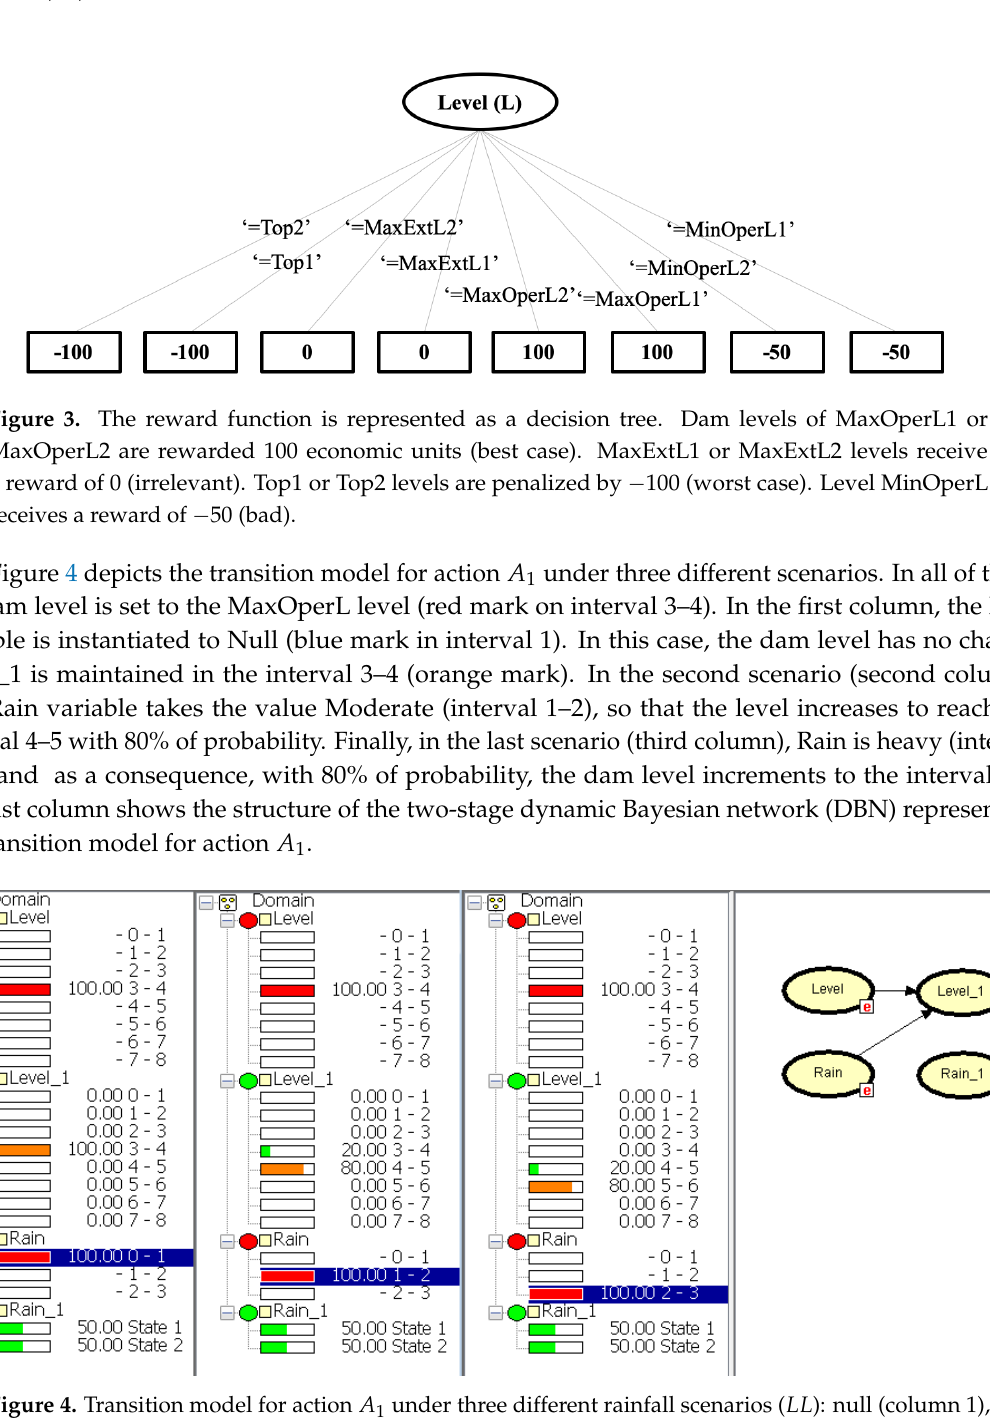
Figure 4. Transition model for action A 1 under three different rainfall scenarios ( LL ): null (column 1), moderate (column 2), and heavy (column 3). Last column shows the structure of the dynamic Bayesian network for this action. The model and scenarios are shown using Hugin